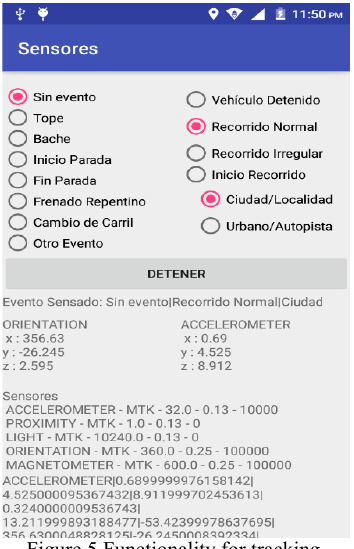
Figure 5 Functionality for tracking.